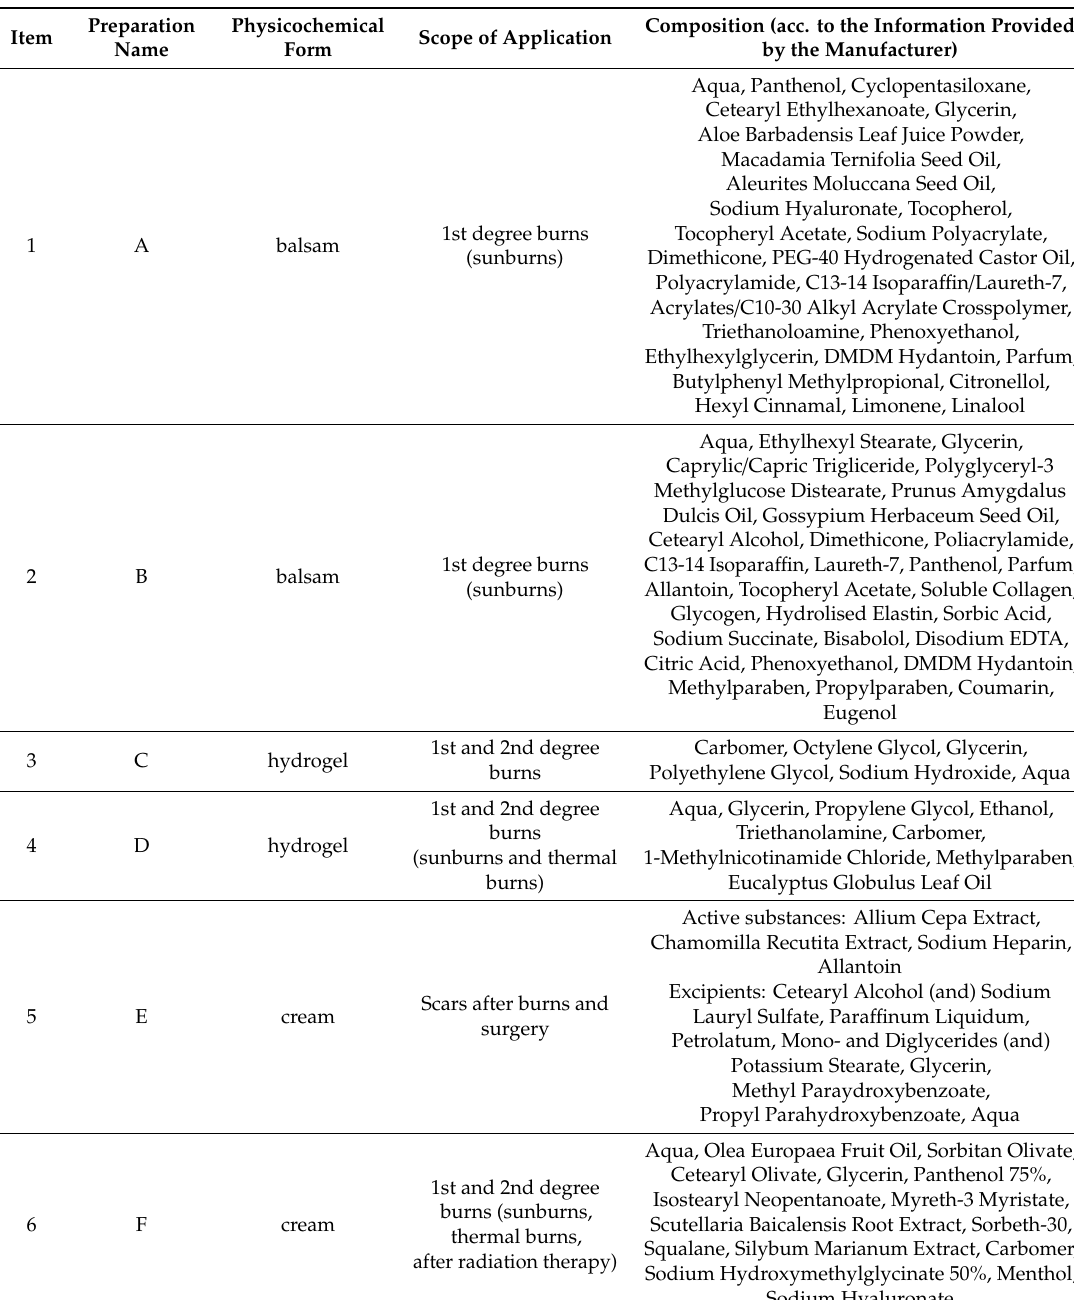
Table 4. Characteristics of the tested market